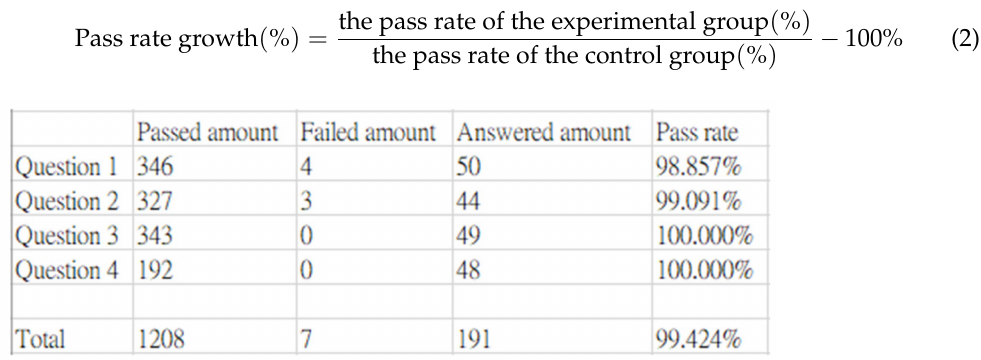
Figure 35. Statistical analyses of the number of questions answered by students in a single week.